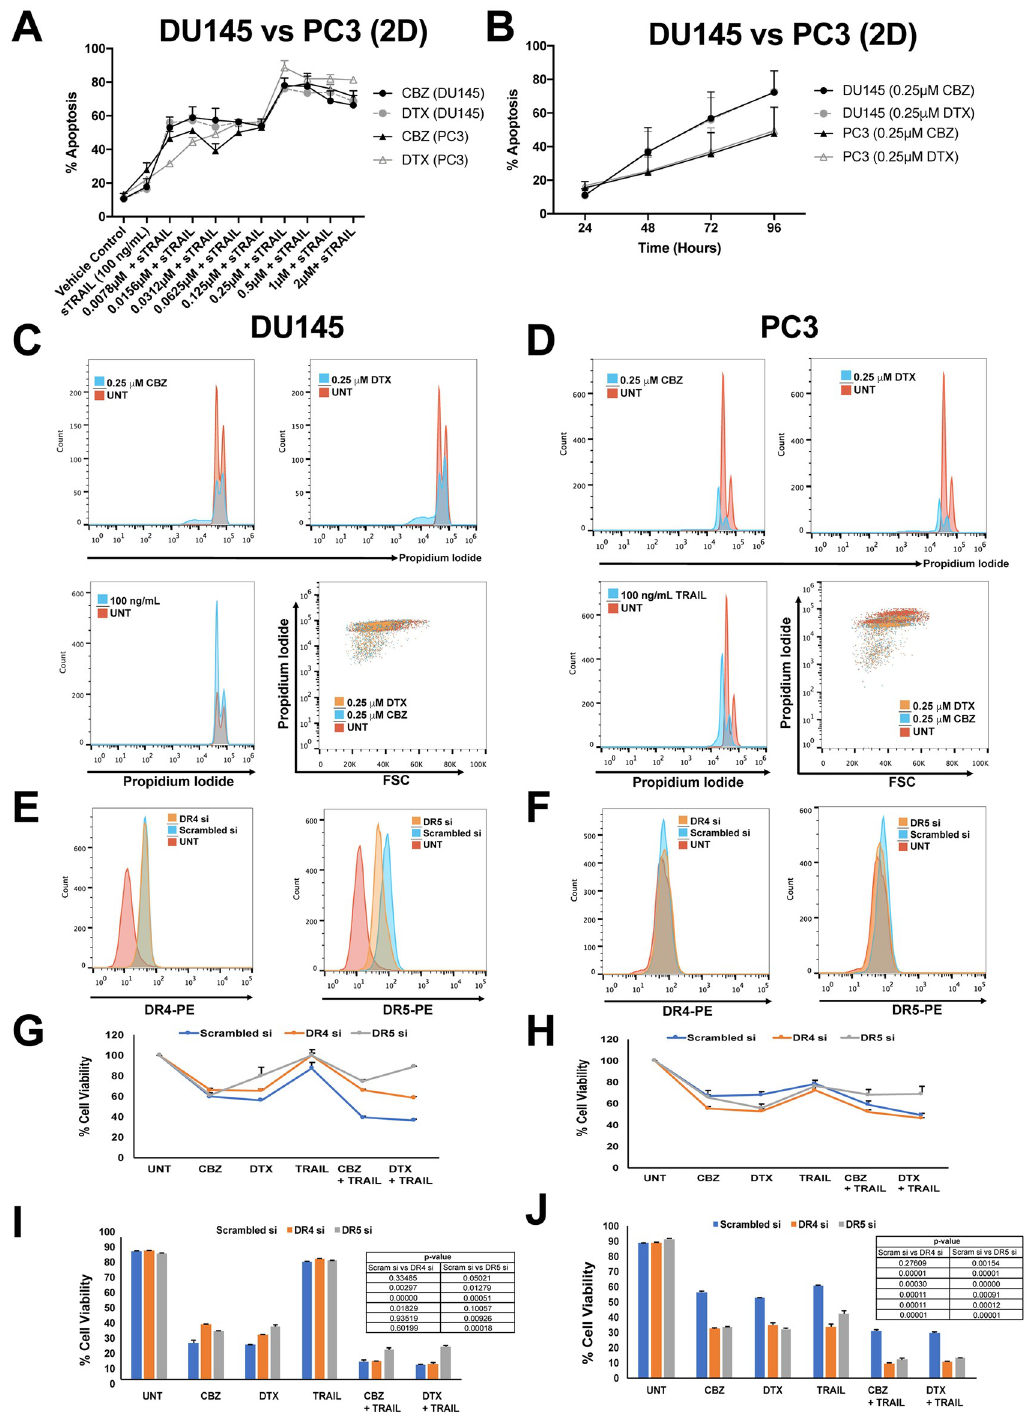
Fig 1. Synergistic effect of taxane + TRAIL treatment in DU145 and PC3 cells with DR4 and DR5 knockdown in 2D cell culture. A . Percentage of apoptosis observed in DU145 and PC3 cells when cells were treated with varying concentrations of taxane plus 100 ng/mL TRAIL. B . Percentage of apoptosis observed after taxane treatment of DU145 and PC3 cells at 24, 48, 72, and 96 hr after initiation of treatment. C, D . Representative propidium iodide histograms of DU145 and PC3 cells treated